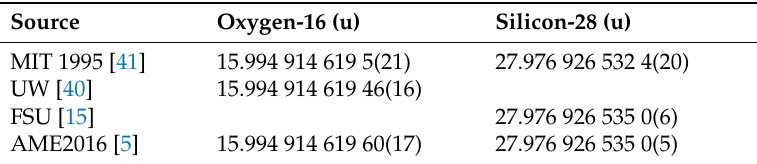
Table 11. Atomic mass values for 16 O and 28